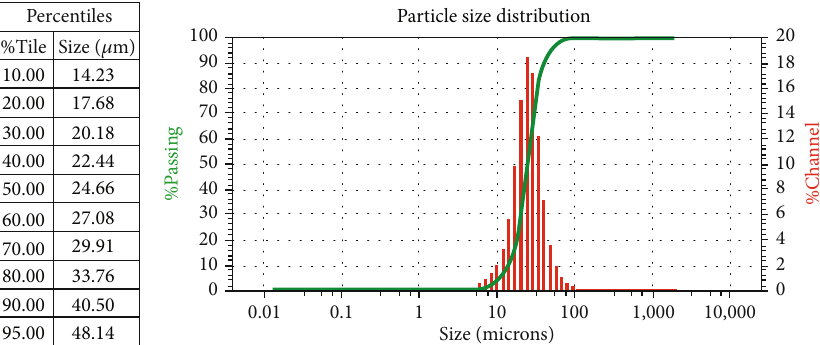
Figure 5: Particle size distribution chart for tung oil